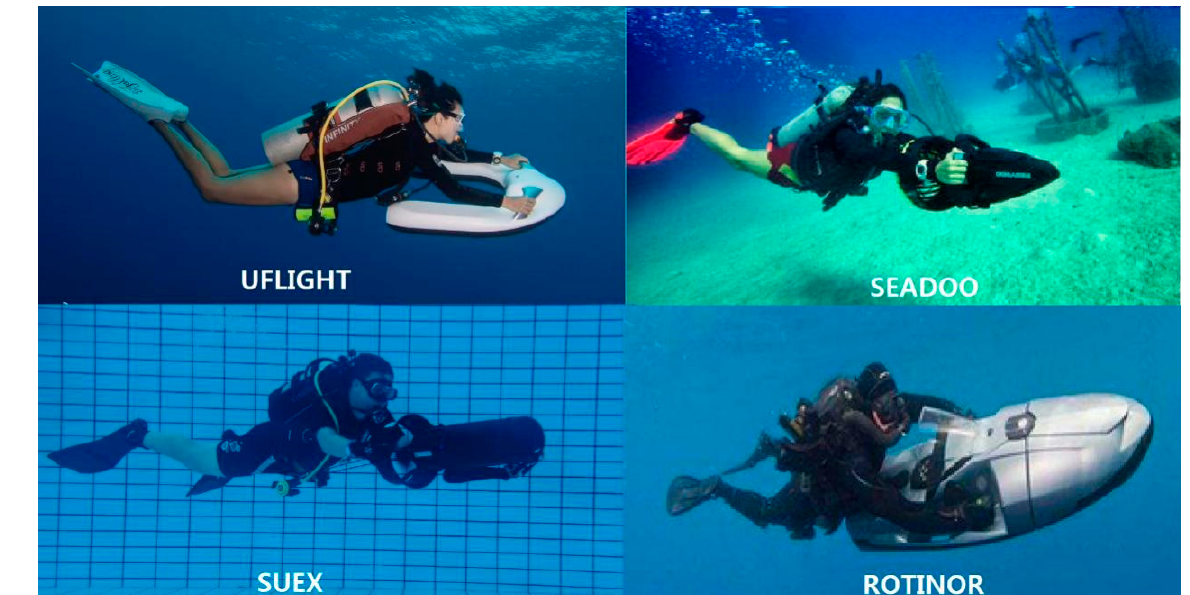
Figure 6. Notations of model’s dimension and posture.